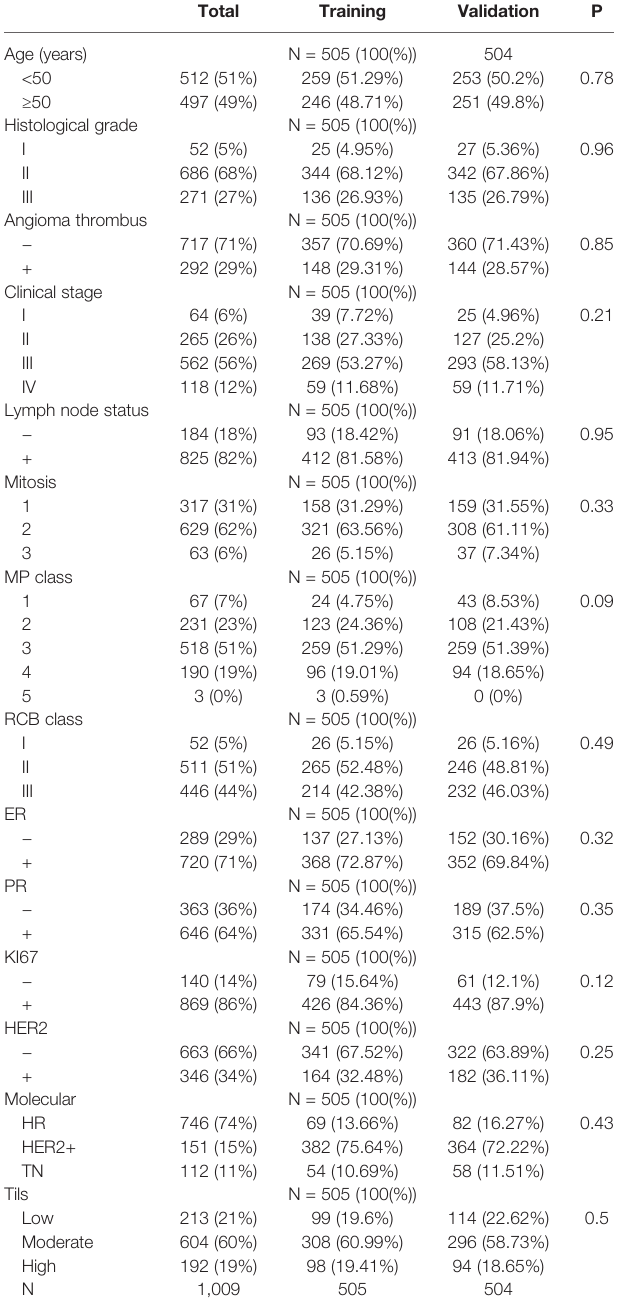
TABLE 1 | Baseline characteristics of